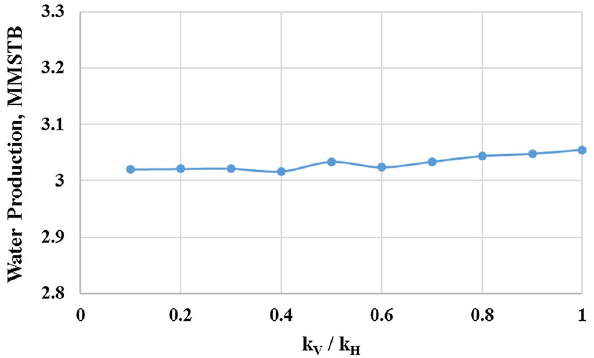
Fig. 34 Total water production for different vertical-to-horizontal permeability ratios